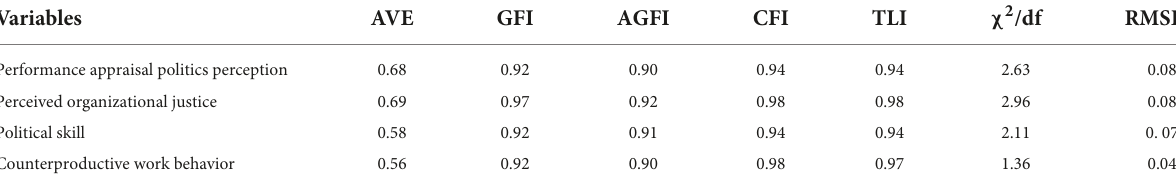
TABLE 1 Confirmatory factor analysis of each variable.